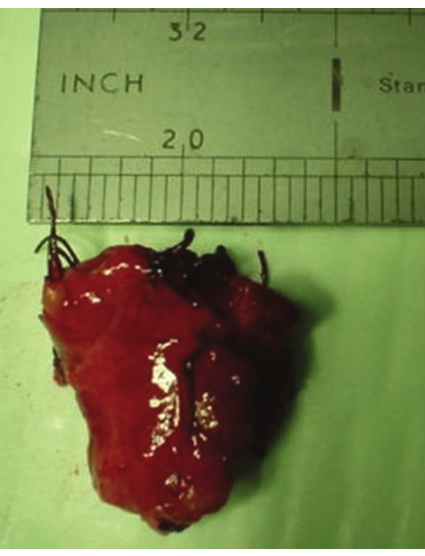
Figure 5: Complete excision of fusiform type I-C choledochal cyst in patient 2 (Table